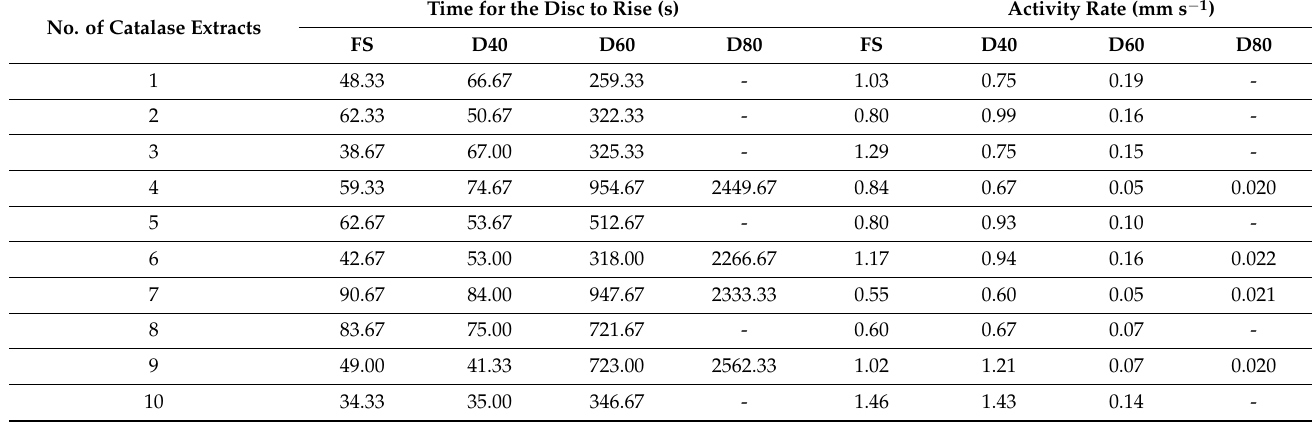
Table A1. Disc rising time (s) and activity rate (mm s − 1 ) for fresh mango and mango dried at 40 ◦